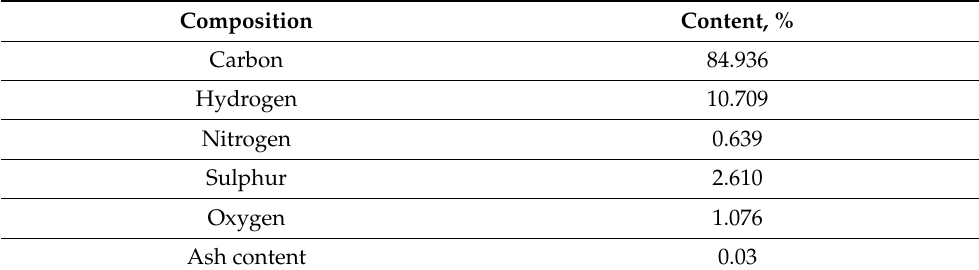
Table 7. Chemical composition of the sediment of the residual fuel mixture.